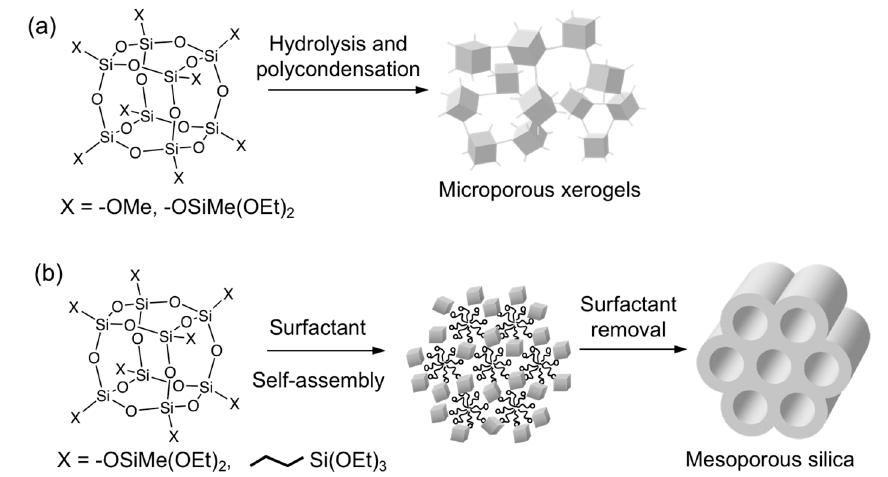
Figure 3. Synthesis of nanoporous materials using alkoxy-functionalized cage siloxanes: ( a ) microporous xerogels by simple sol–gel reactions and ( b ) mesoporous materials by surfactant-directed self-assembly processes.